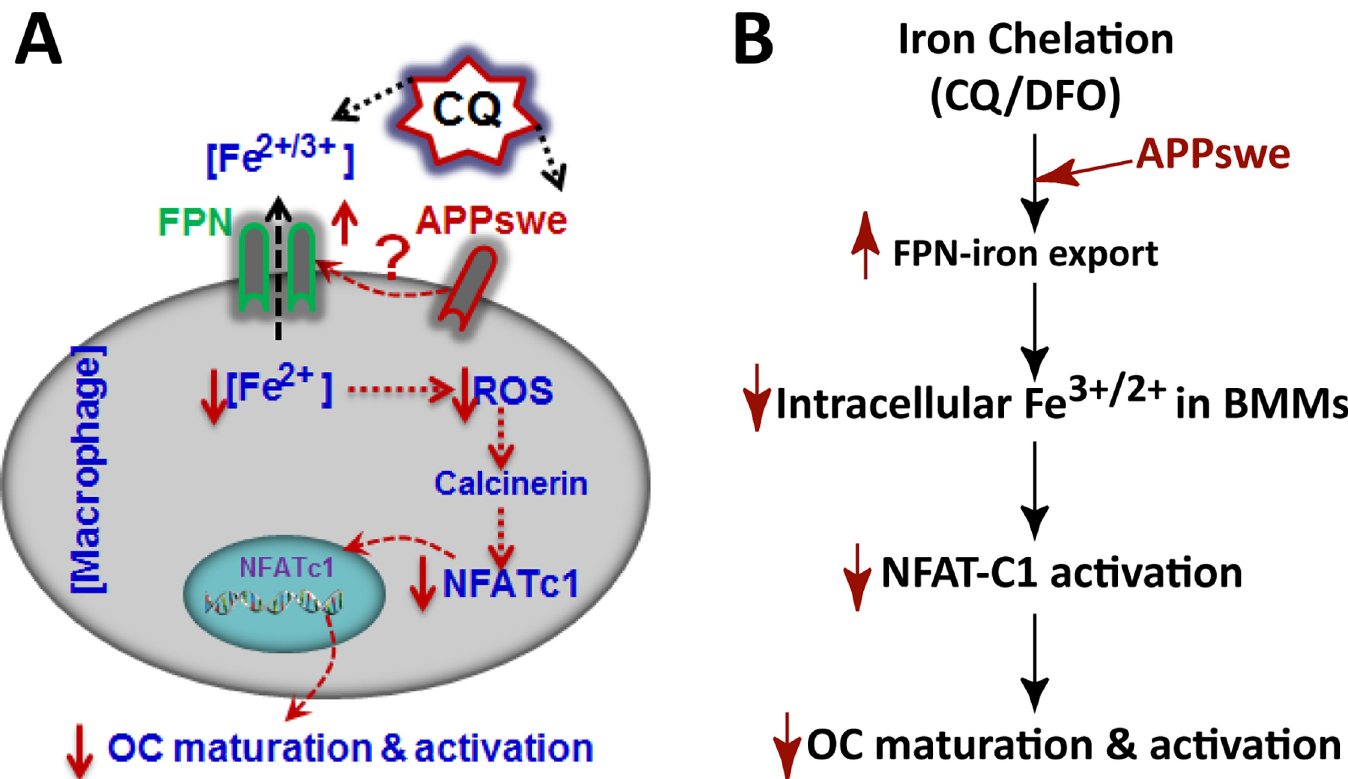
Fig 9. Illustration of a working model for inhibition of OC-genesis by iron chelation. Iron chelation by CQ or DFO inhibits OC maturation, which might be due to its role in increasing FPN-mediated iron exporting in BMMs, thus, reducing intracellular iron levels, impairing NFAT-C1 activation, and decreasing OC- maturation. This effect is enhanced by expression of APPswe in